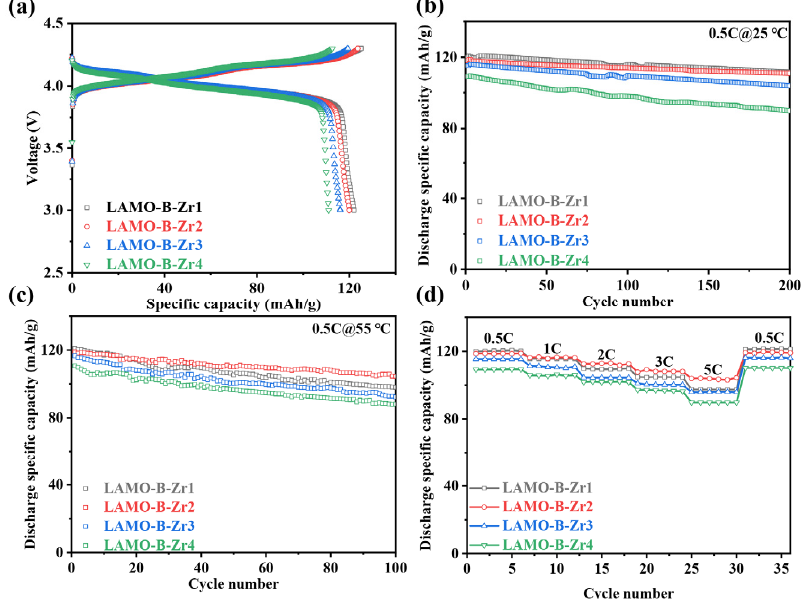
Figure 6. The electrochemical performance of the Li 2 ZrO 3 -coated LAMO-B-Zr cells. ( a ) The initial charge–discharge profiles at 0.2C and 25 °C; The cycling performance with 0.5C rate at ( b ) 25 °C and ( c ) 55 °C. ( d ) The rate performance at 0.5C, 1C, 2C, 3C and 5C, respectively.